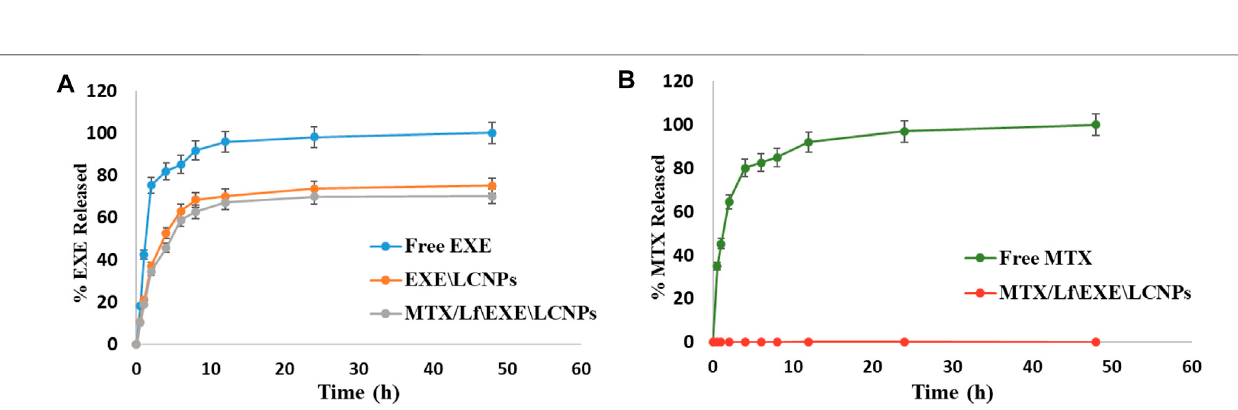
Frontiers in Chemistry |